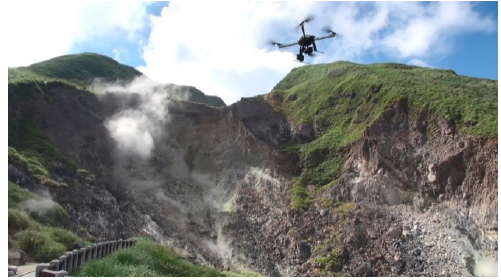
Figure 7. In situ situation of UAV flying.